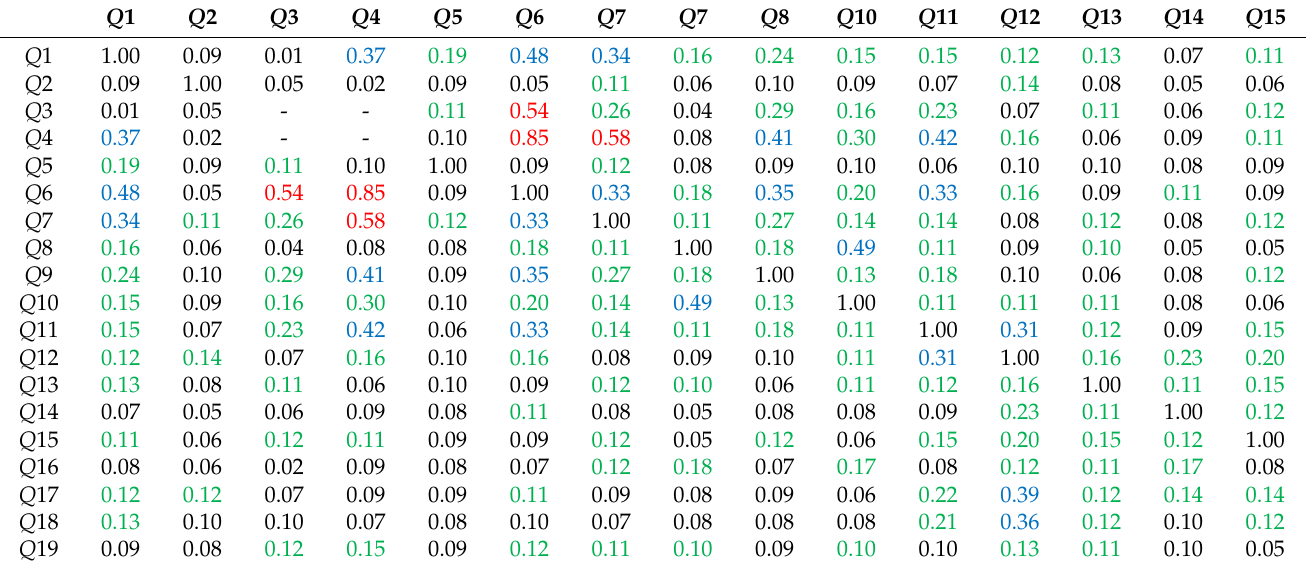
Table A2. The values of the Cramer’s V coefficient for questions Q 1– Q 15 (questions numbers ( Q ) according to